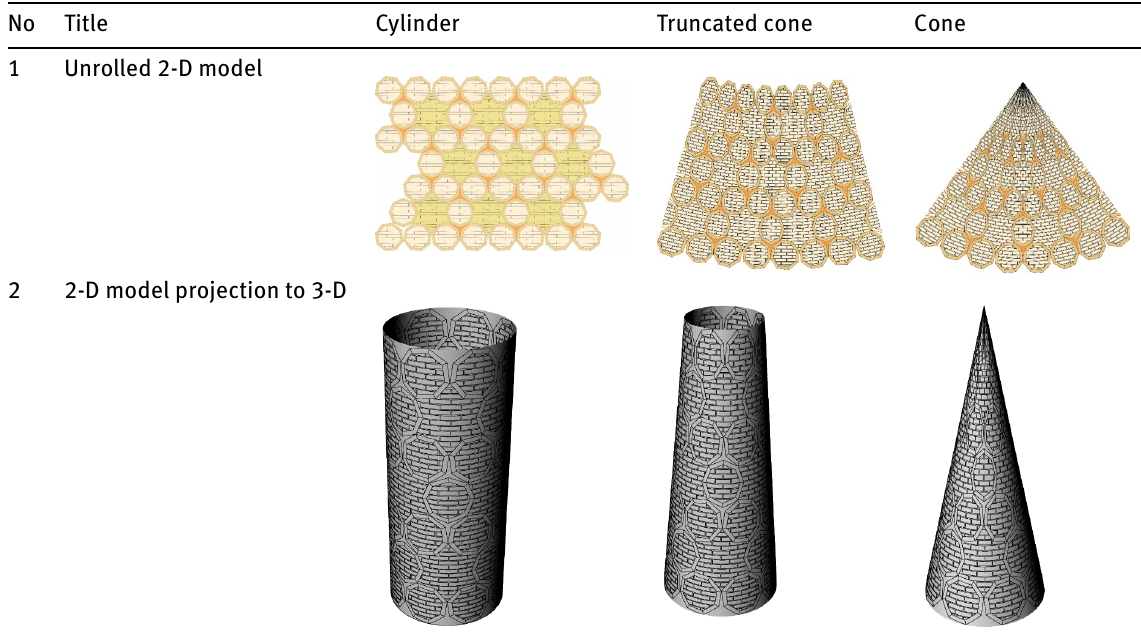
Table 3: The change process in girih pattern of the brickwork in the Chehel-Dokhtaran minaret modeled on different 3-D shapes (cylinder, truncated cone, and cone).